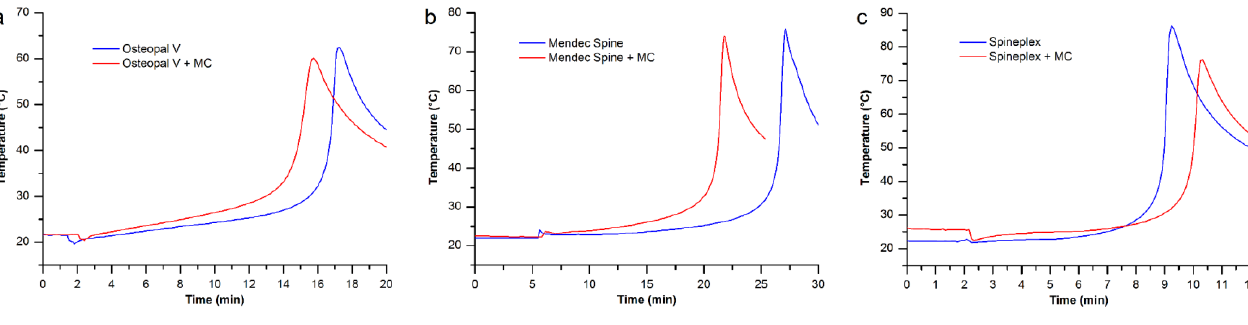
Figure 9. The maximum temperature comparisons between the unmodified and modified bone cements: ( a ) Osteopal ® V bone cement; ( b ) Mendec ® Spine bone cement; and ( c ) Spineplex™ bone